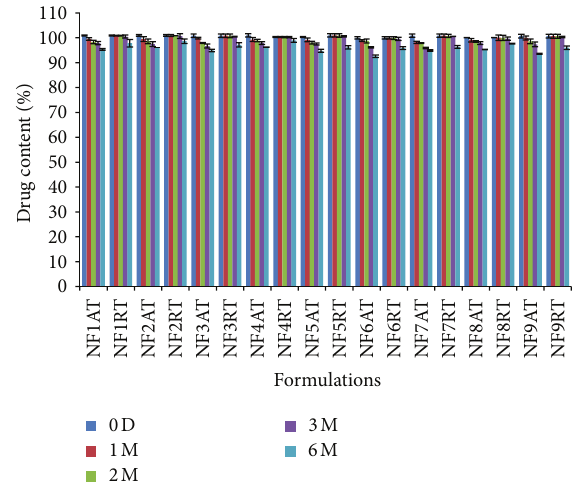
Figure 9: Stability of naproxen sodium tablets under accelerated condition and room temperature. Mean ± S.D. ( 𝑛 = 3 ). AT: accel- erated temperature (40 ∘ C), RT: room temperature, D: days, and M: